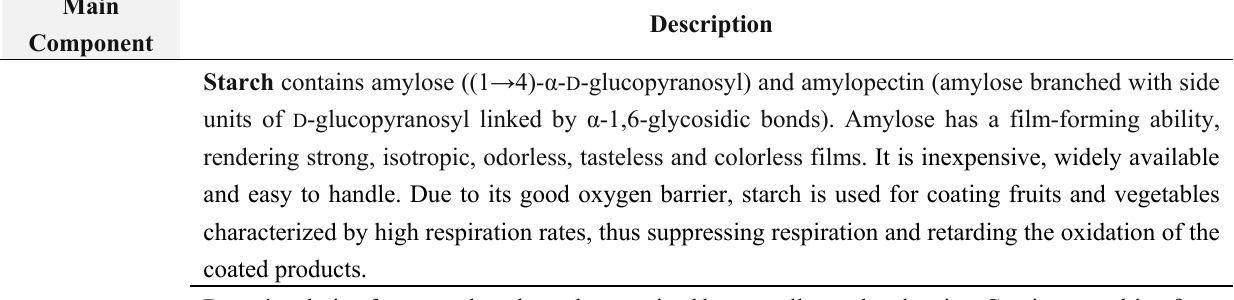
Table 1. Main polysaccharides, proteins and lipid compounds used for edible